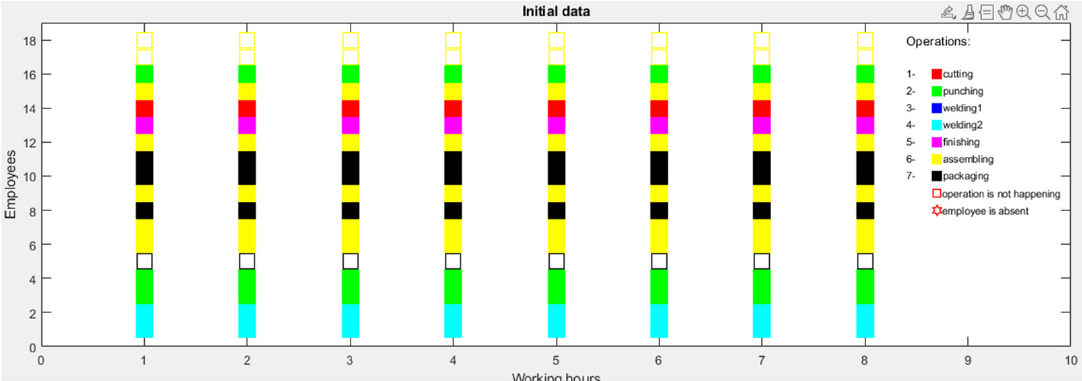
Figure 9. Initial data, 2nd case.